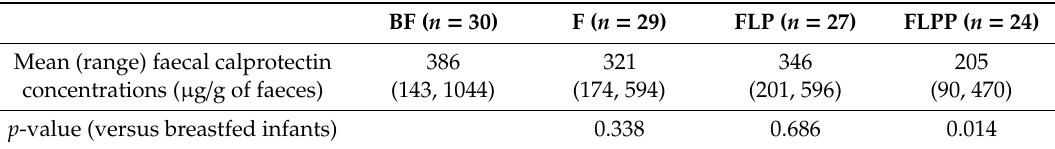
Table 2. Fecal Calprotectin concentrations (mean at 2 and 4 weeks). PP data set.